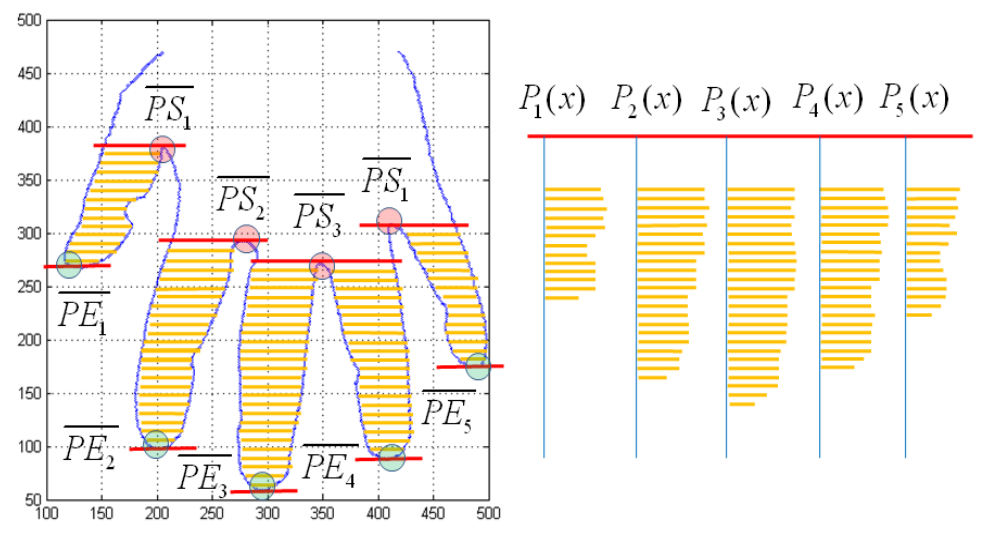
Figure 11. The feature extraction for the profile of